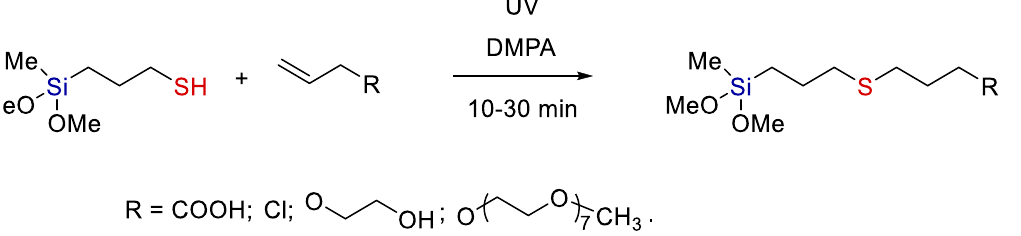
Figure 6. A scheme of the modification of mercaptopropylmethyldimethoxysilane by radical thiol-ene addition [32]. Adopted from Ref.